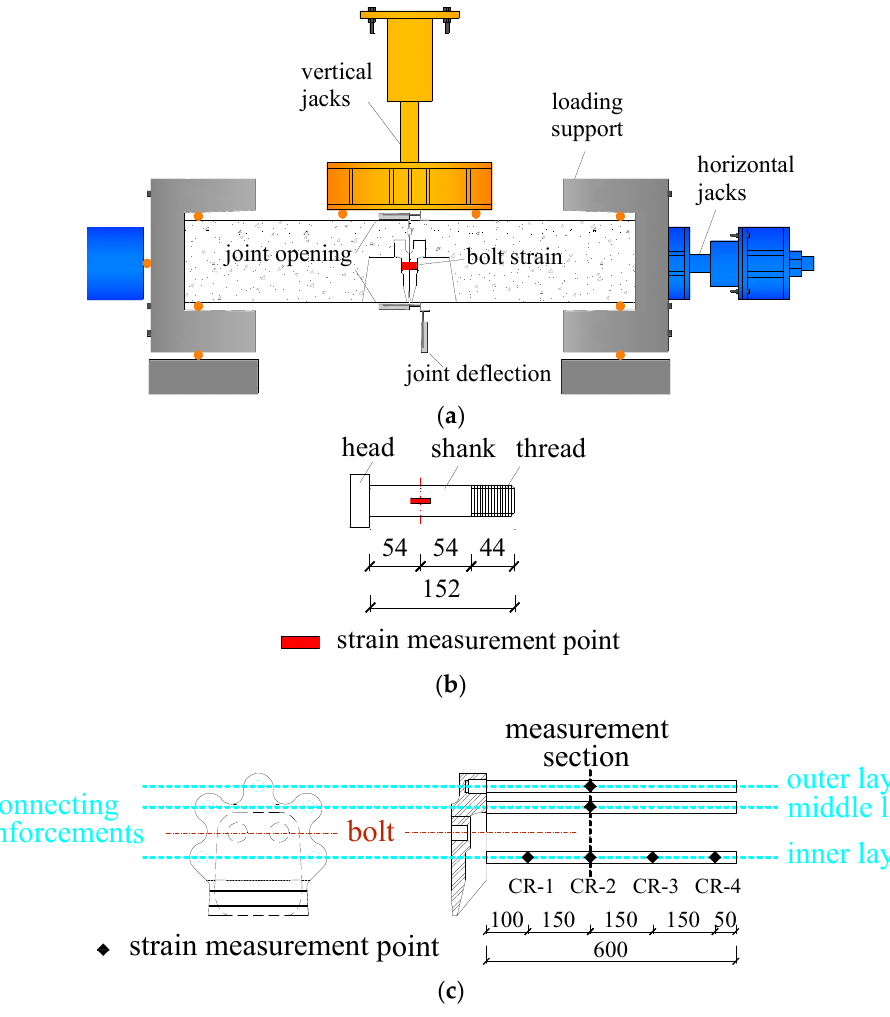
Figure 9. Measurement points: ( a ) joint opening, joint deflection, and bolt strains; ( b ) details of a bolt strain measurement point (unit: mm); ( c ) strain measurement points on the connecting reinforcements (unit: mm). Table 1. List of measurement points.